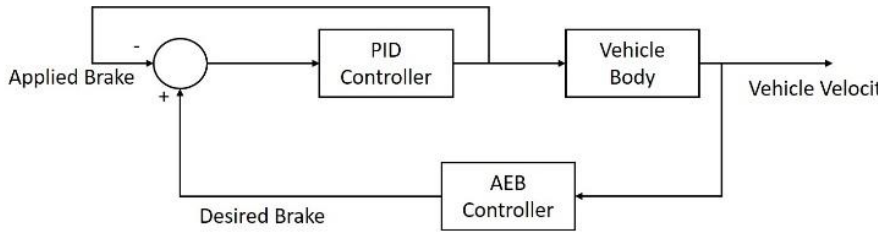
Figure 9. Block diagram of PID-based braking control.